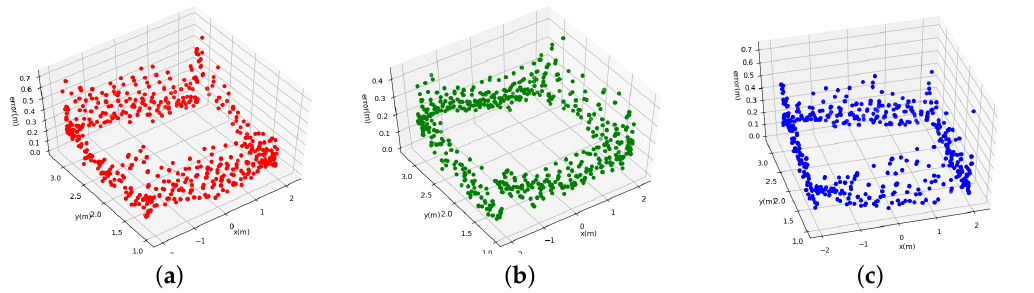
Figure 5. The positioning error at different locations with w =25. ( a ) The first object; ( b ) The second object; ( c ) The third object.